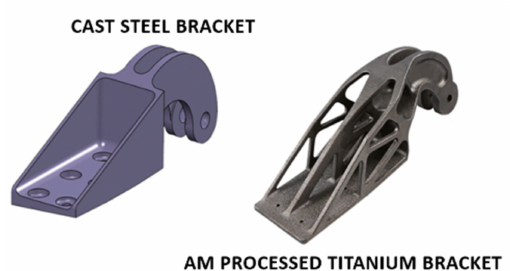
Figure 14. Optimized design of Nacelle hinge bracket using AM approach [82].